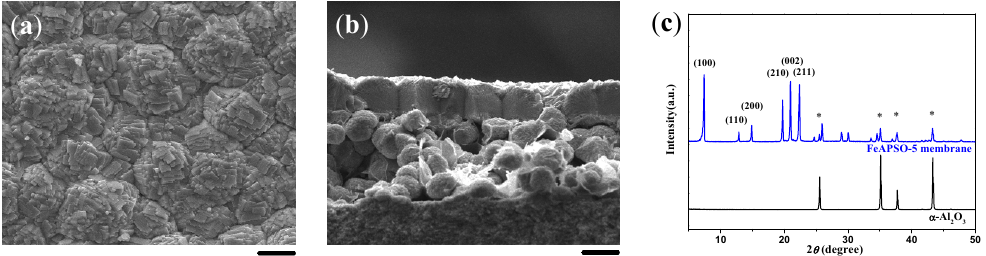
Figure 9. ( a ) Top view and ( b ) cross-sectional SEM images together with ( c ) the corresponding XRD pattern of the double-layer FeAPSO-5 membrane induced by a layer of MMW chitosan using pseudo-boehmite as the Al source. Scale bars correspond to 20 μ m. The asterisks in XRD patterns mark the peaks originating from the α -Al 2 O 3 substrate.